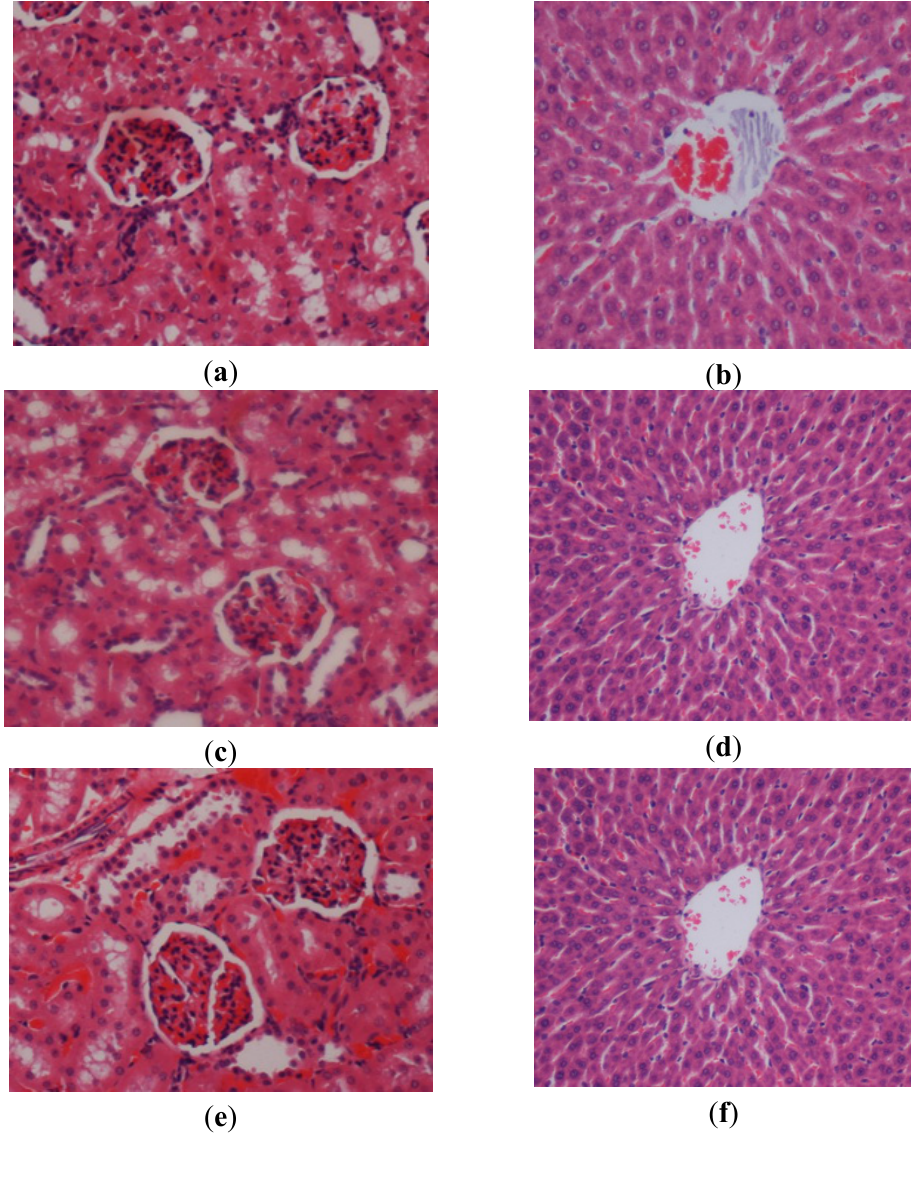
Figure 1. Histological sections of liver and kidney after the acute toxicity test. Rats (1a and 1b) treated with vehicle (CMC). Rats (1c and 1d) treated with 0.5 g/kg P. jiringa extract. Rats (1e and 1f) treated with 2 g/kg P. jiringa extract. There is no significant differences in structures of liver and kidney between treated and control groups (H & E stain